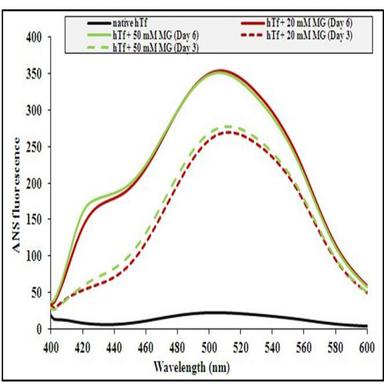
ANS fluorescence. ANS fluorescence emission spectra of hTF in native form and incubated with varying concentration (20 mM and 50 mM) for different time period. For ANS fluorescence, excitation is carried out at 380 nm while the recoding range is 400–600 nm.